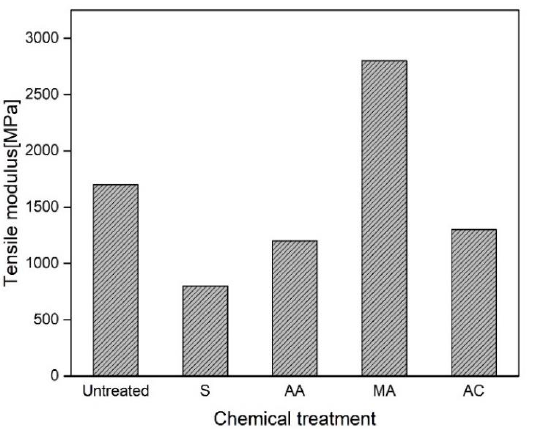
Figure 24. Tensile modulus of untreated and different chemical-treated agaves fibre-reinforced polyester composite. Reprinted with permission from Reference [125]. Copyright 2008, with per- mission from Elsevier.